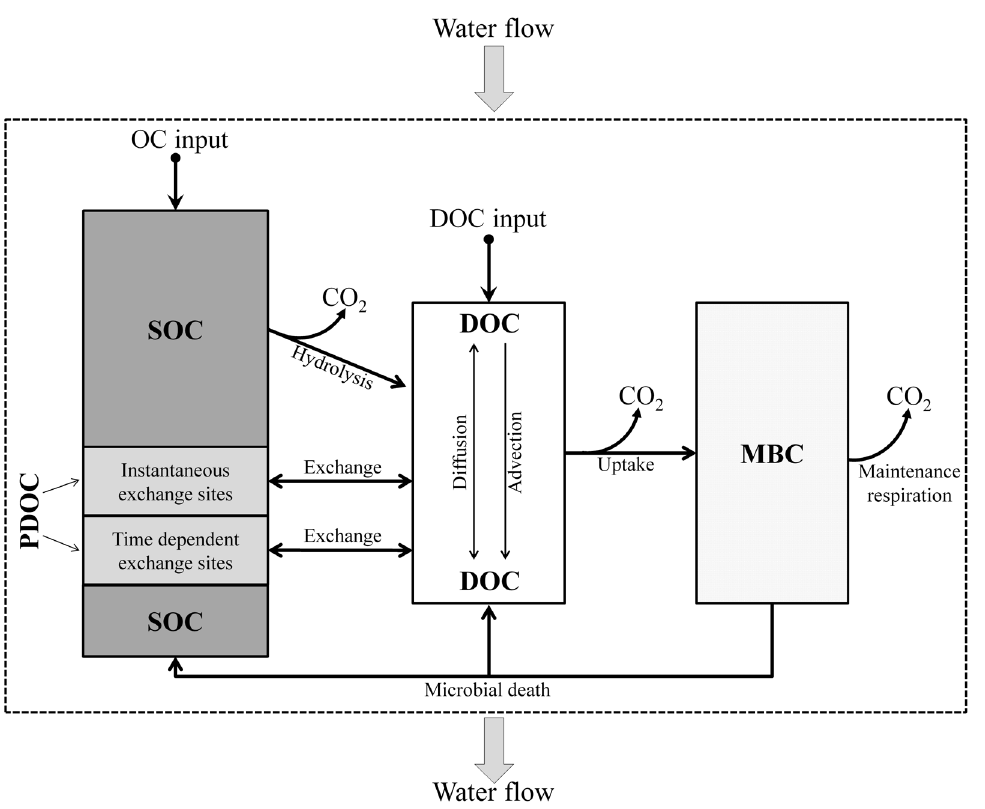
Figure 2. Schematic of the process-based model that was used to describe the simultaneously occurring production, fate, and transport of dissolved organic carbon and microbial biomass dynamics. DOC: dissolved organic matter; PDOC: potentially dissolvable OC that currently remains in the solid phase; SOC: soil organic matter; MBC: microbial biomass carbon.